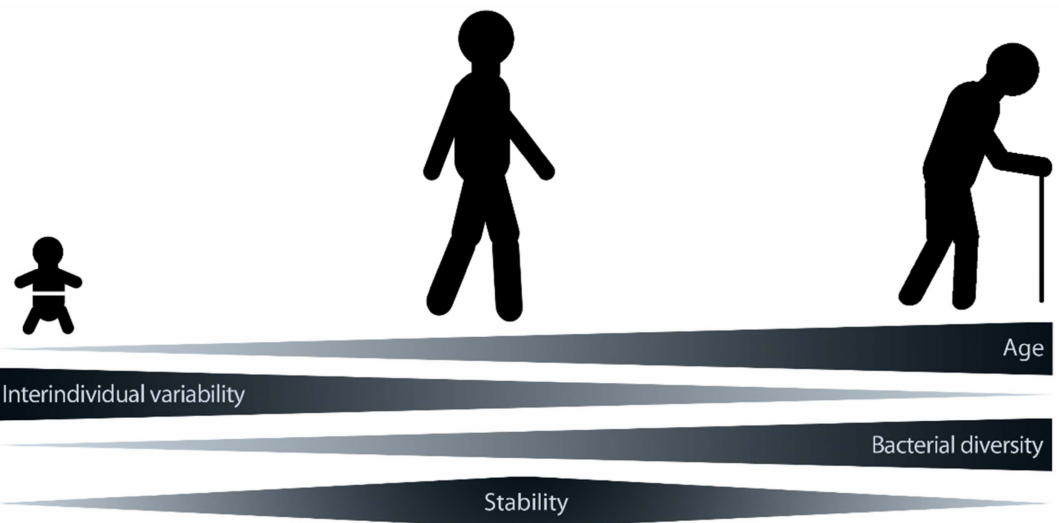
Figure 3. Stability of microbiota composition over the lifetime. During one’s lifetime, not only does the microbial composition change, but so too does its stability and diversity, which contributes to a more resilient microbial composition in adults (modified after